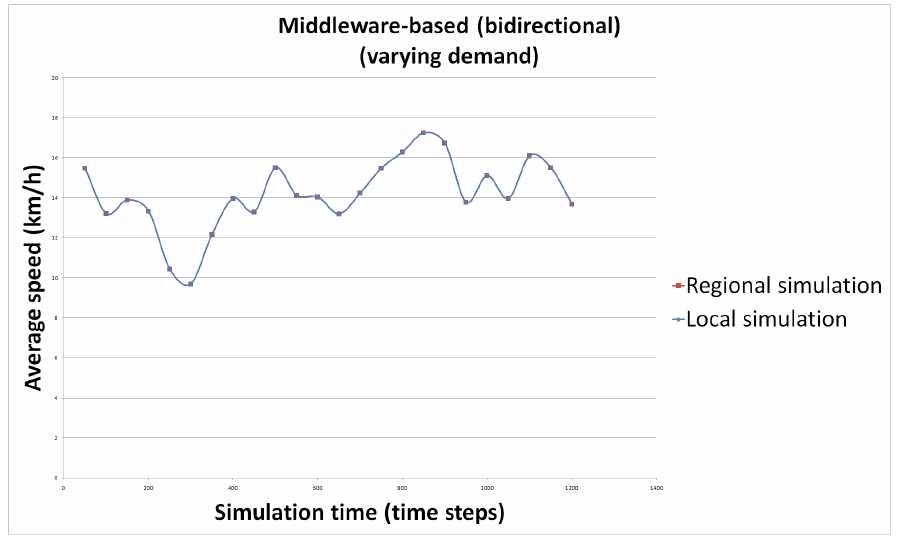
Figure 12. Average speeds for Scenario